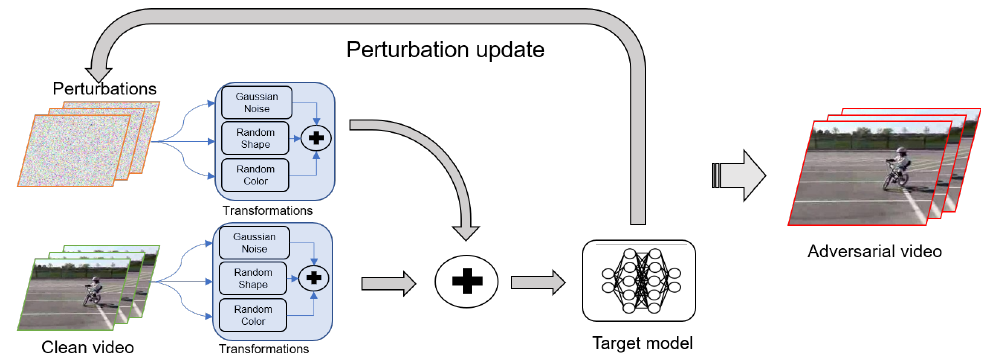
Figure 2. Overview of the video-augmentation-based adversarial attack.